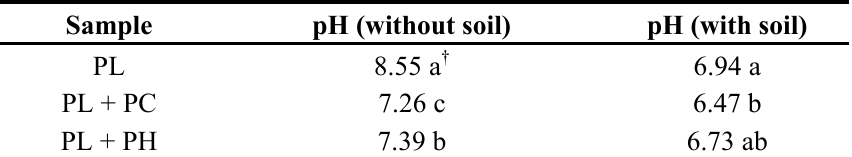
Legend for Table 2: PL refers to poultry litter; PC and PH refer to biochar from pine chips and peanut hulls, respectively. ‡ Within each column, different letters (a,b) mean significant difference between treatments at 0.05 level of significance; † means one observation missing. Table 3. Initial pH readings of poultry litter alone or in combination with soil, with or without acidified biochars.